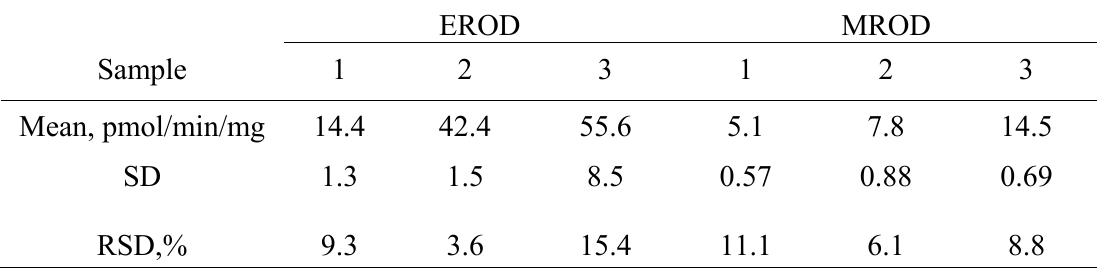
EROD: ethoxyresorufin O -deethylation; MROD: methoxyresorufin O -demethylation; SD: standard deviation; RSD: relative standard